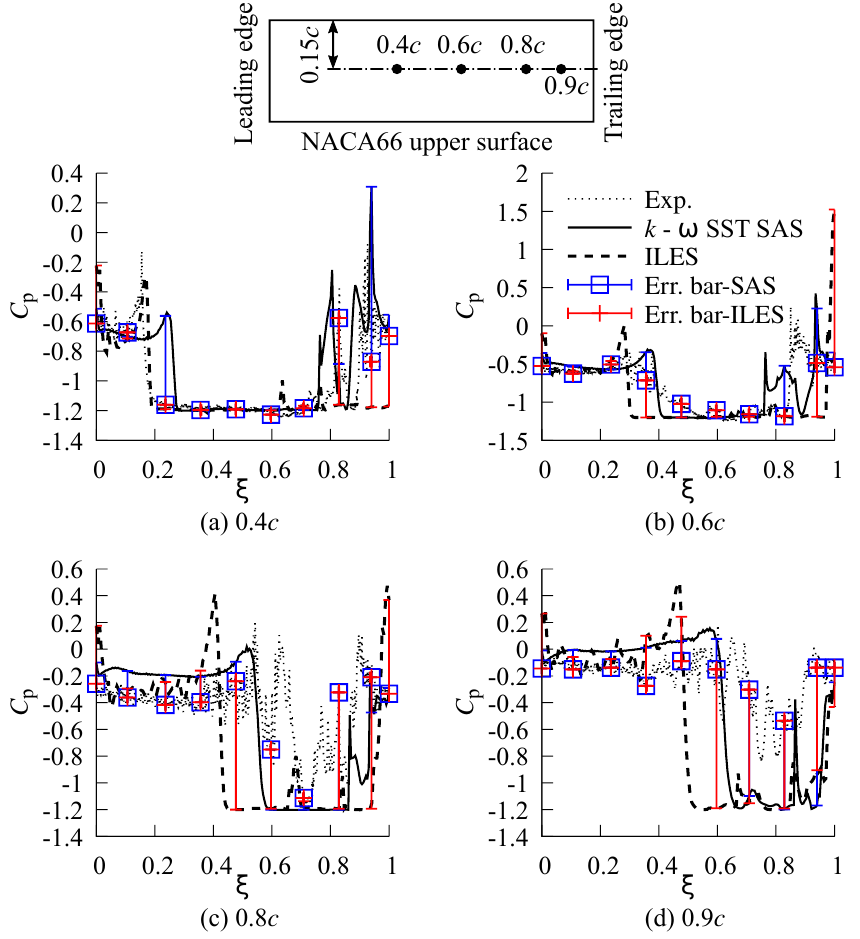
Figure 7. Comparison of pressure coefficient, C p , among